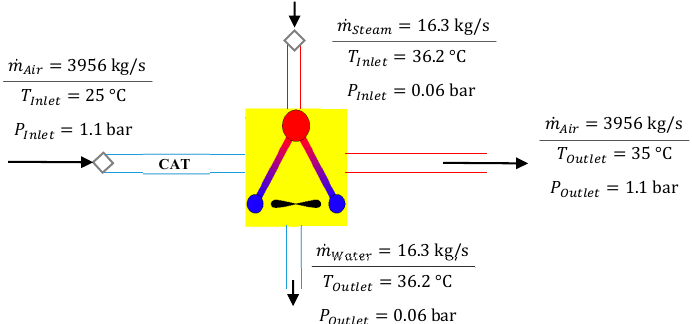
Figure 1. Simplified scheme of a pipe connected to the air condenser with the flow conditions of both incoming and exiting air and steam streams.